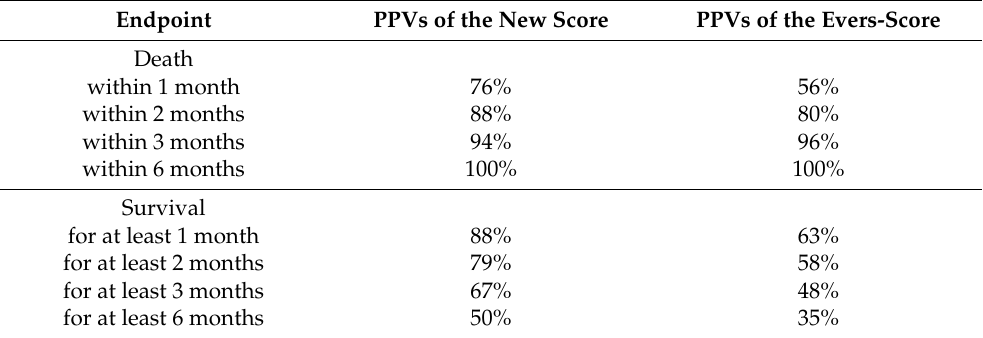
Table 5. Comparison of the new instrument and the previous Evers-Score [10] with respect to accuracy to predict death within 1, 2, 3, and 6 months (worst prognostic groups) and survival for at least 1, 2, 3, and 6 months (best prognostic